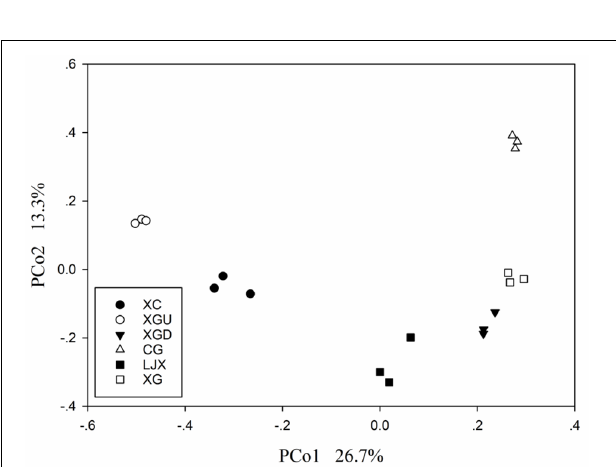
FIGURE 4 | Principal coordinate analysis (PCoA) score plot of different riparian soil samples based on weighted UniFrac metrics. Two categories were clustered, including uncontaminated group – XC and XGU and contaminated group – XGD, LJX, XG, and CG.